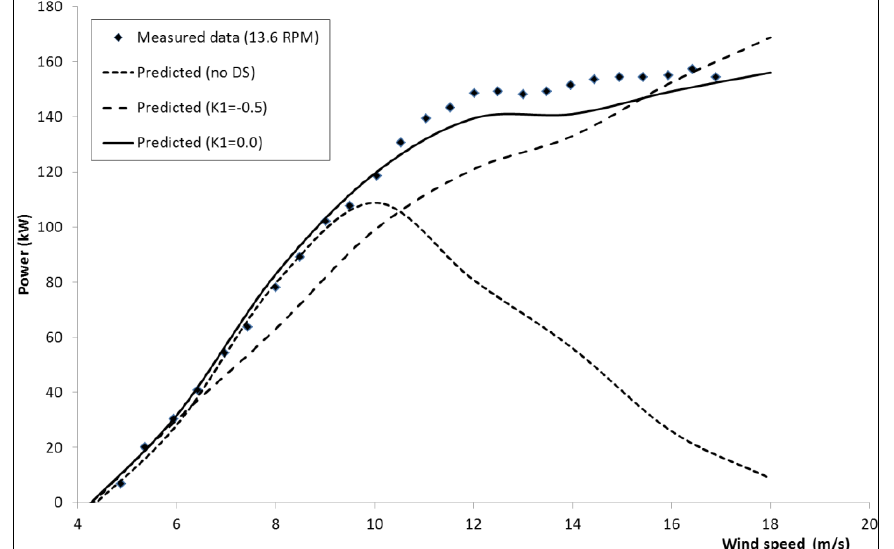
Figure 11. VAWT-850 H-rotor power vs. wind speed at 13.6 rpm.